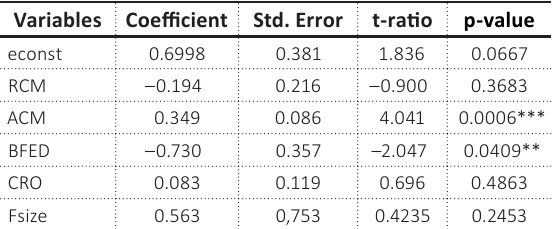
Table 5. Regression estimates for model 2: fixed